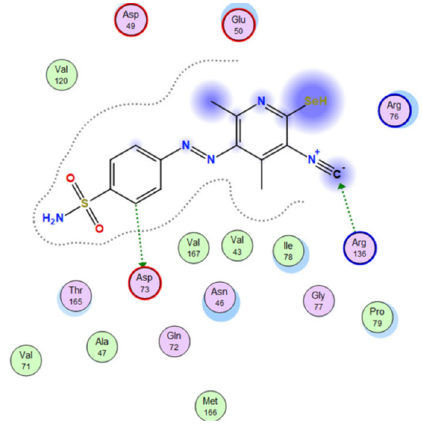
Figure 20. 3D interaction of selenium compound 210c with 1kzn protein [87].